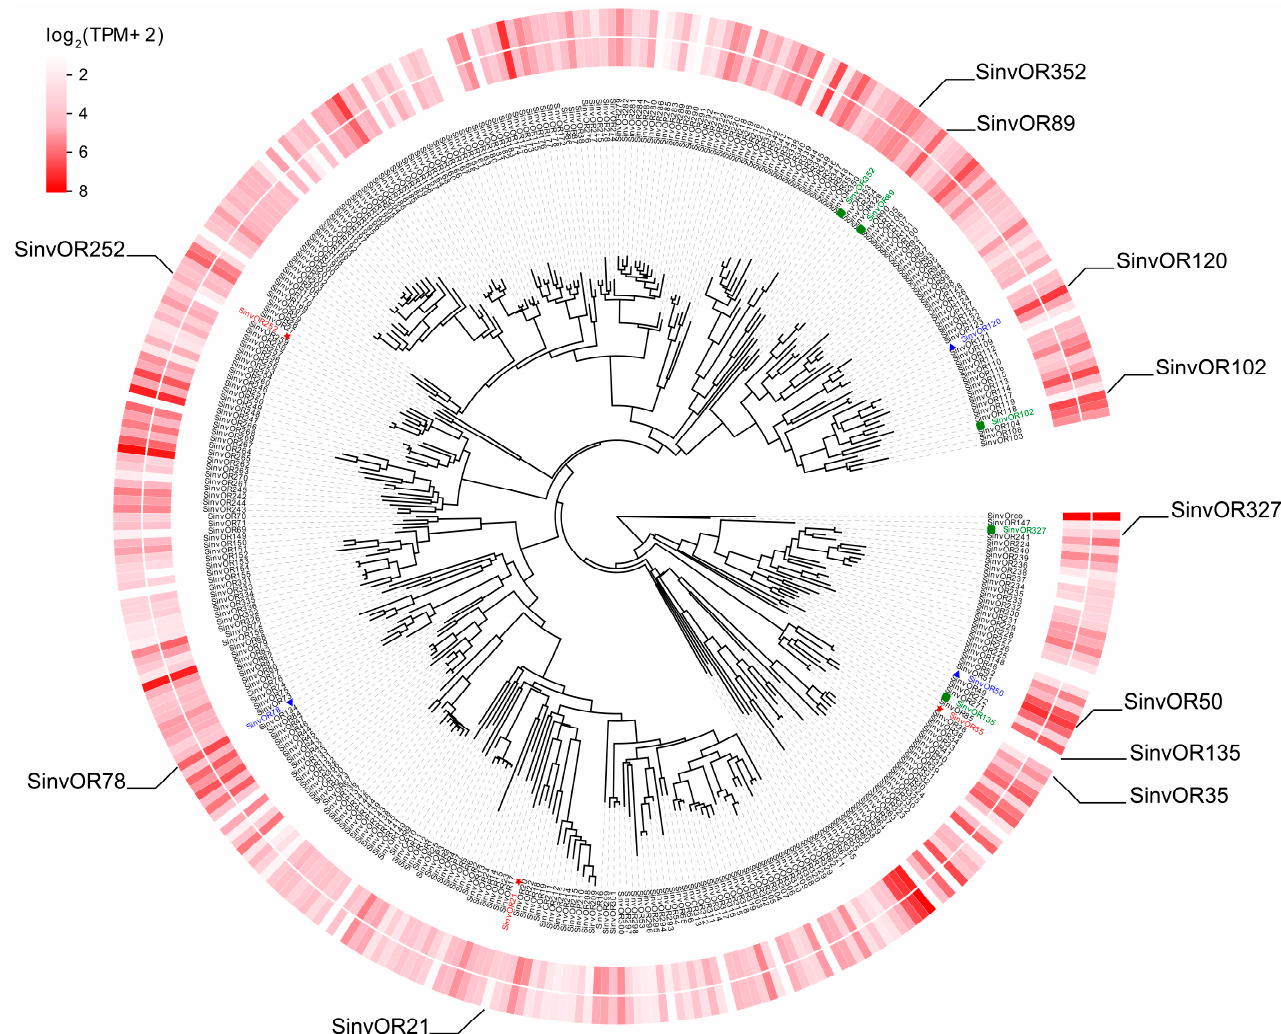
Figure 6. Expression levels of 356 OR genes in the antennae of S. invicta workers. The inner loop indicates the expression levels of ORs in polygyne colonies containing SB/SB workers; outer loop indicates expression in monogyne colonies containing SB/SB workers. Blue font and triangles indicate the highly expressed 9-exon OR subfamily members. Red font and pentagons indicate differentially expressed ORs in antennae of workers in different social types. Green font and squares indicate highly conserved ORs of S. invicta in three Formicidae species.